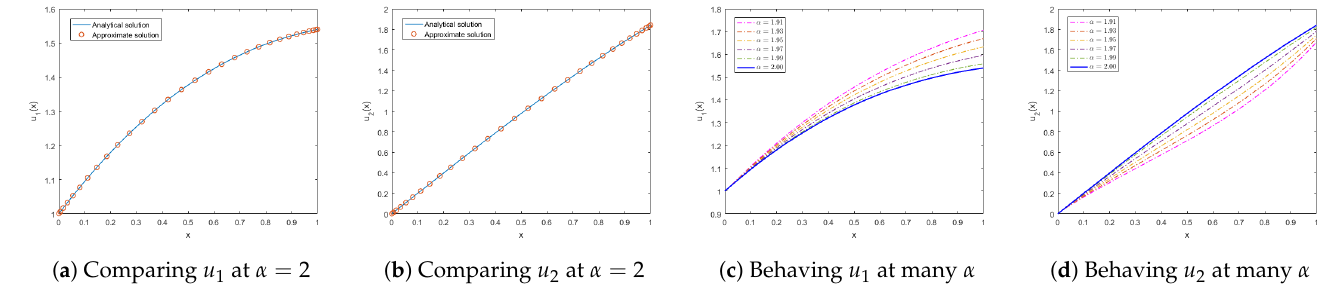
Figure 2. The behaviors of the approximate solutions in Example 2. We plot the obtained approximate solutions u 1 ( x ) and u 2 ( x ) compared to their analytical solutions as depicted in Figure ( a , b ). ( c , d ) show the behavior of the obtained approximate solutions for the proposed system of FIDEs with the nodal point M = 30 for different values of the fractional orders α ∈ { 1.91,1.93,1.95,1.97,1.99,2 }